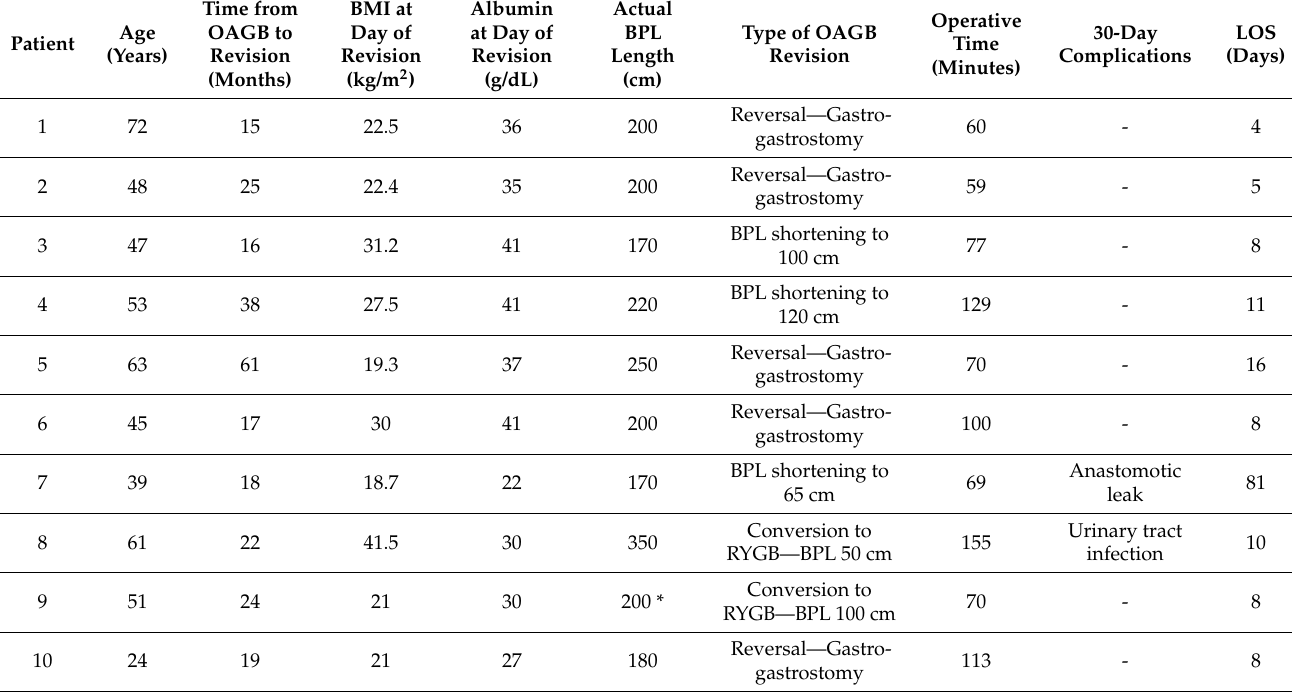
Table 3. Perioperative data of OAGB